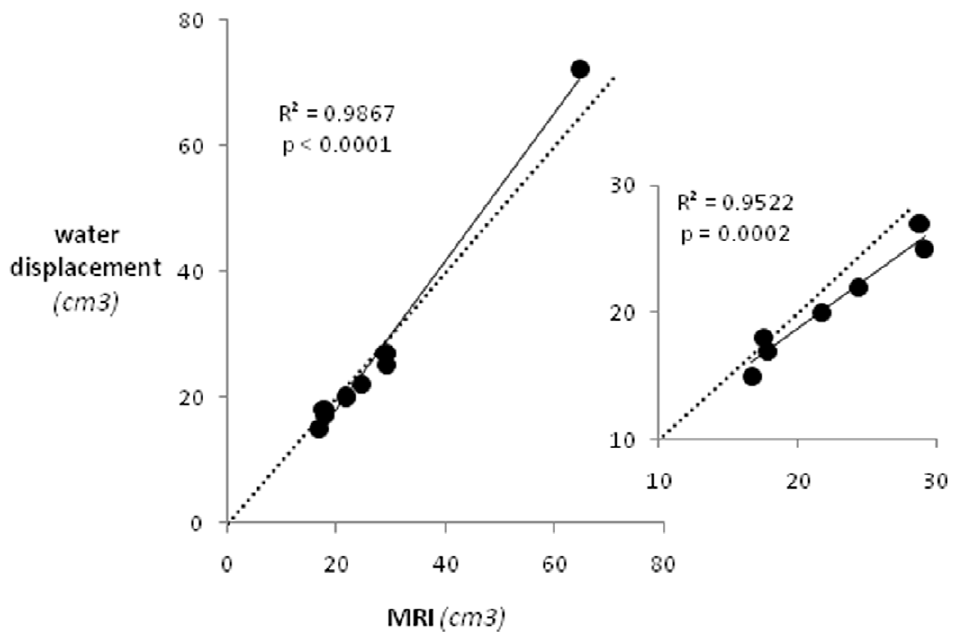
Figure 2. The strong correlation of pancreatic volumes measured by MRI and ex vivo. The correlation remains strong even without the point from an animal with an exceptionally large pancreatic volume. The dashed line indicates identity line. doi:10.1371/journal.pone.0055991.g002 insulin and the other for blood sampling. A bolus of 50% glucose injected 20 minutes later. Blood samples were collected for solution (0.3 g glucose/kg body weight) was injected at time 0 and a bolus of regular human insulin (0.03 U/kg body weight) was